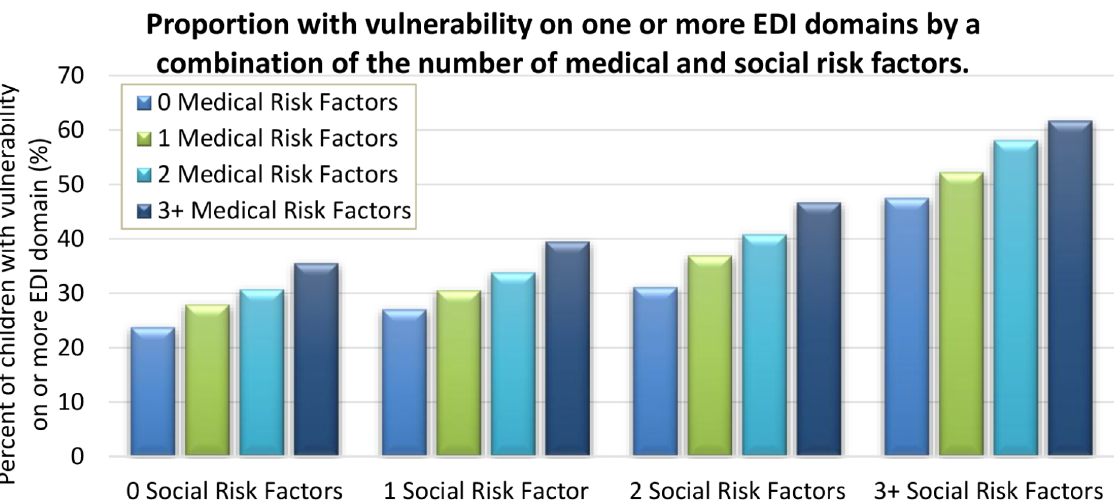
Figure 3: Proportion of kindergarten students with linked Early Development Instrument records with vulnerability in one or more domains by the number of social and medical risk